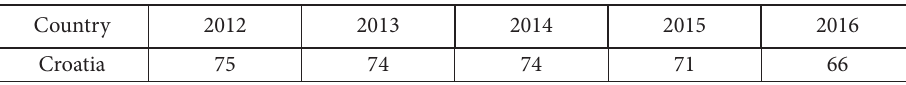
Table 1. Loans in foreign currency (% of total credits) 2012−2016 in Croatia (source: CEE Banking Sector Report, 2017)